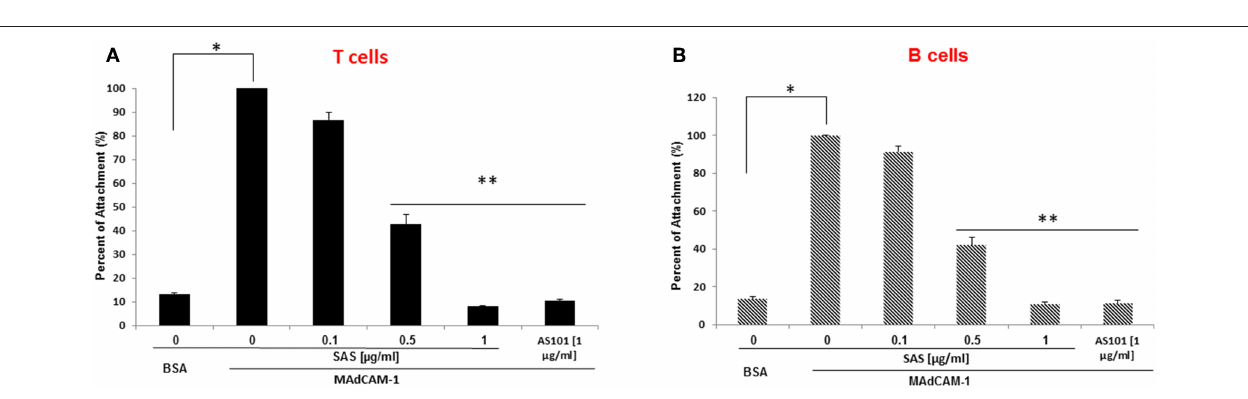
FIGURE 3 | AS101 and SAS inhibit in vitro the activity of the a4 β 7 integrin on both T and B spleen cells of NOD mice. T and B spleen cells from 10 week old mice were sorted by FACS, using anti CD3 or anti B220 antibodies. Single cells (5 × 10 5 ) of each lineage ( A = T cells; B = B cells) were cultured on BSA or MAdCAM-1-coated microwells for 2h in the presence or absence of different concentrations of SAS or 1 µ g/ml AS101. The cells were washed twice and then subjected to the XTT reagents according to the manufacturer’s instructions. The results represent means ± SE from three different experiments. * p < 0.01; ** p < 0.001 decrease vs. MAdCAM-1 without AS101 or SAS (SAS